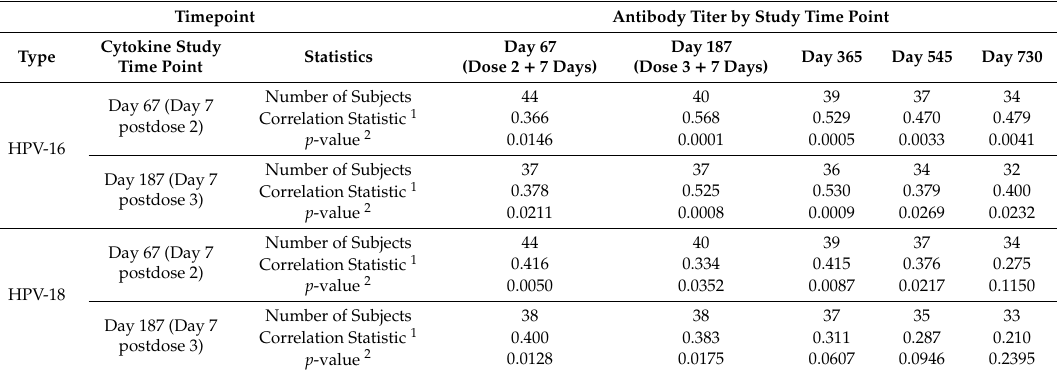
Table 3. Correlation between CD4 + T Cell and antibody responses for HPV-16 and HPV-18 in the prospective